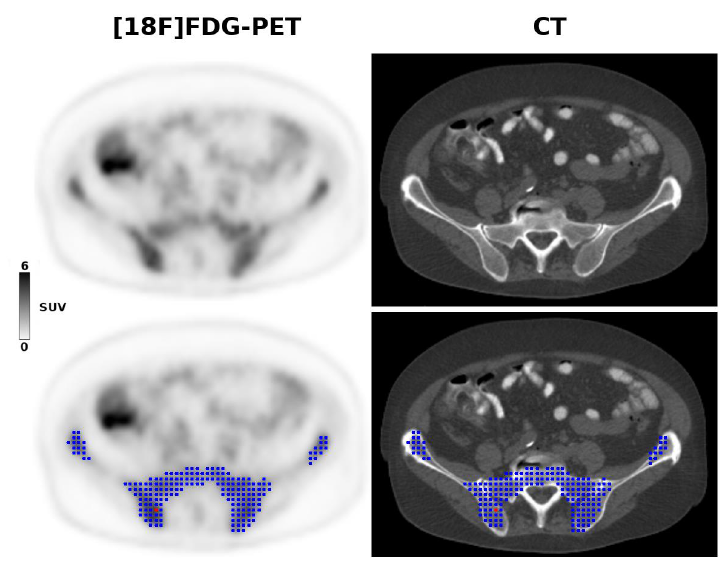
Figure 2. A 68-year-old patient with stage IV mantle cell lymphoma due to biopsy-proven bone marrow involvement. The [18F]FDG-PET 3D radiomic analysis is based on the metabolic tumor volume (blue) within the pelvis, constructed using the previously recommended 41% SUVmax threshold, and controlled by CT anatomy. The red dot shows the voxel with the highest SUV (i.e., the SUVmax).